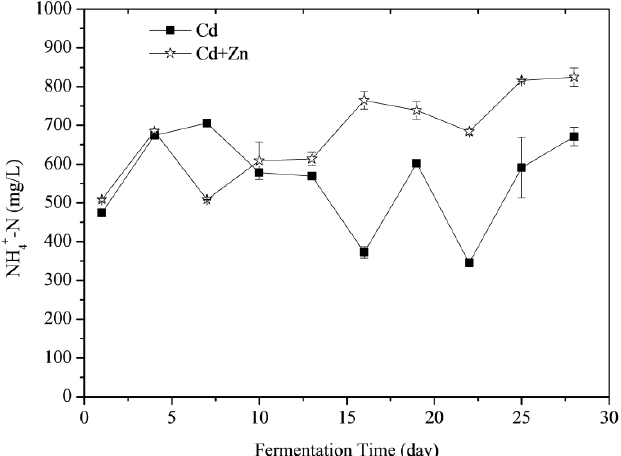
Figure 5. Impact of Cd and Cd + Zn addition on ammonia nitrogen (NH 4 + -N) concentrations during the fermentation.